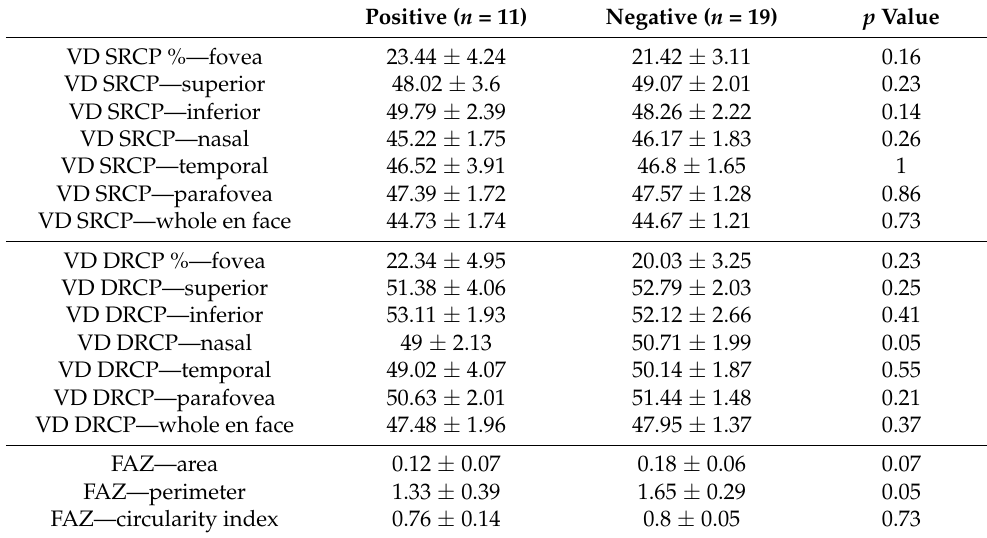
Table 6. Comparison of OCTA parameters among SLE patient using